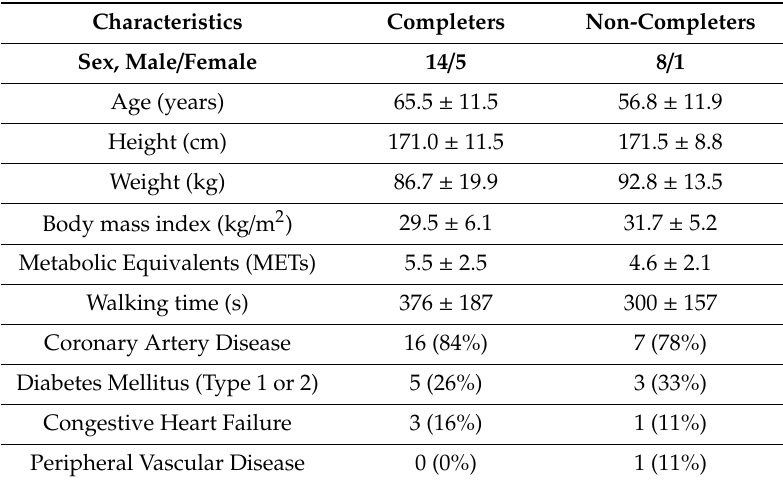
Table 1. Baseline patient characteristics ( N = 28). Mean ± SD or n